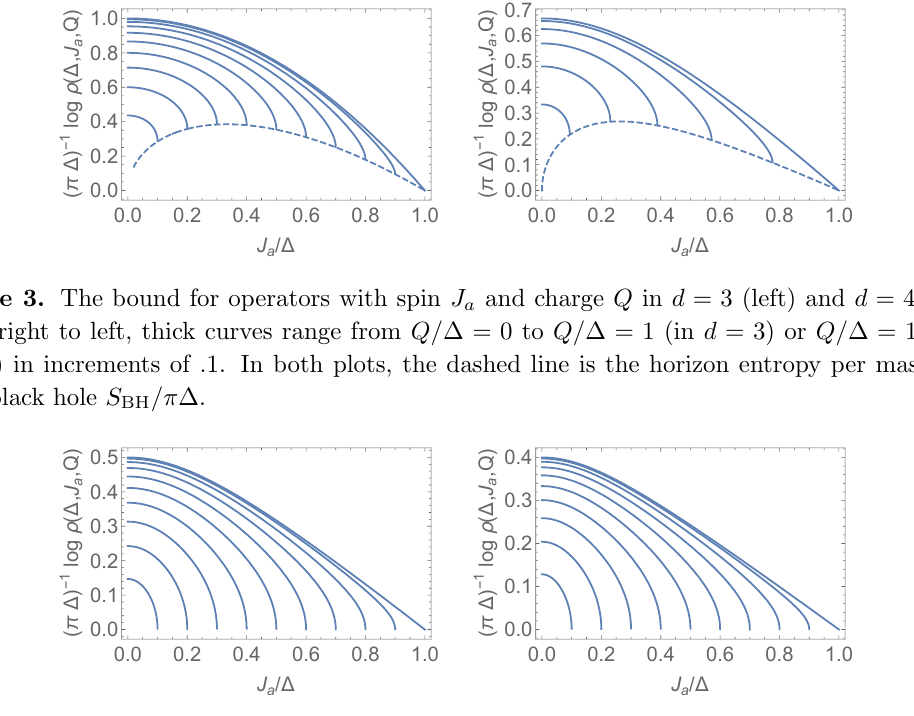
Figure 4. The bound for operators with spin J a and charge Q in d = 5 (left) and d = 6 (right). From right to left, thick curves range from Q= (cid:1) = 0 to Q= (cid:1) = 1. The bound vanishes at the BPS limit j J j + Q =